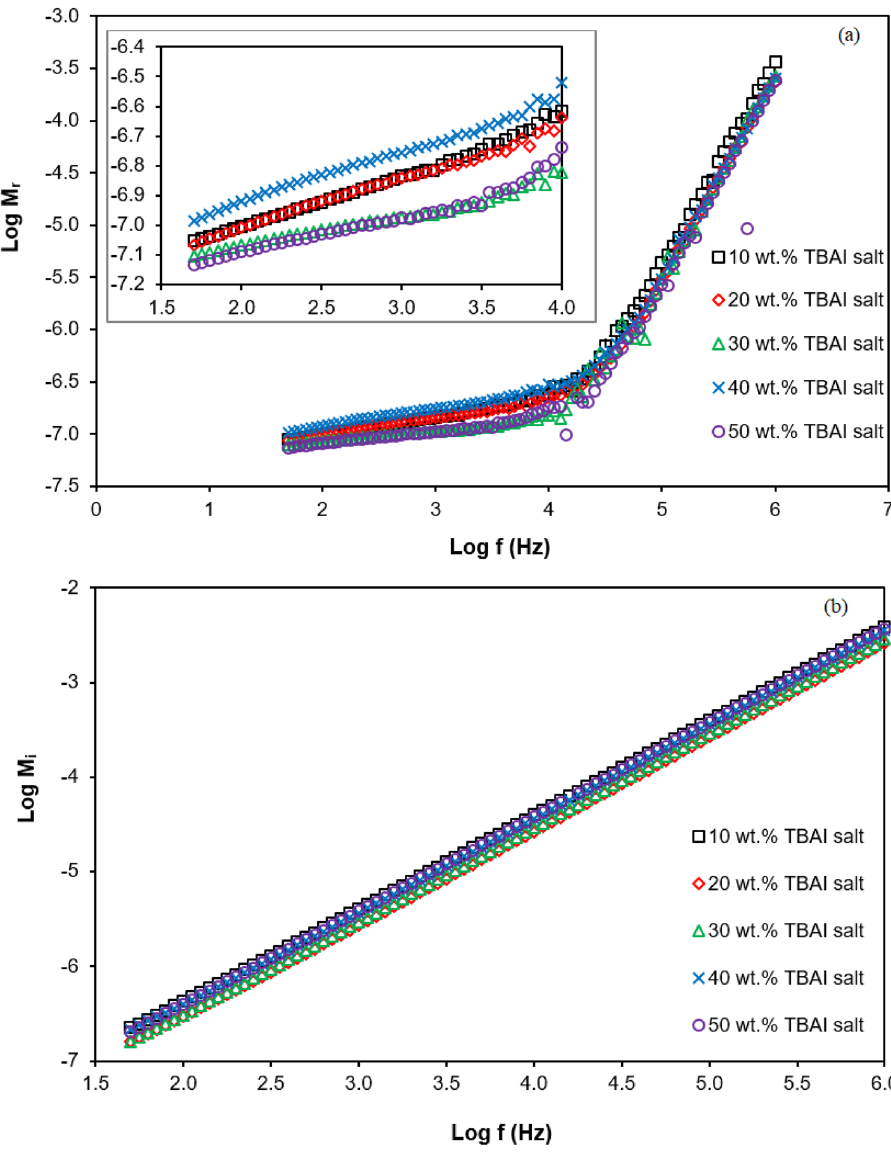
Figure 9. Variation of real ( M r ) and imaginary ( M i ) of electrical modulus with frequency for PUA-TBAI-I 2 GPE